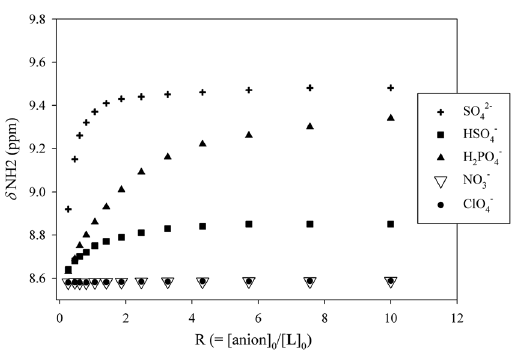
Figure 3. 1 H NMR titration curves of L (2 mM) with an increasing amount of various oxoanions (R = [anion] 0 / [ L ] 0 ) in DMSO- d 6